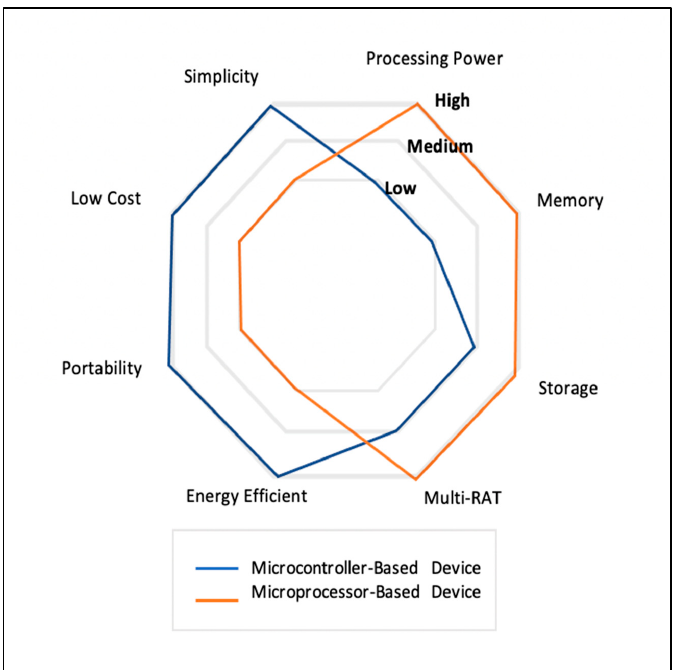
Figure 2. Comparison between the main characteristics of devices powered either by microcontroller or microprocessor.